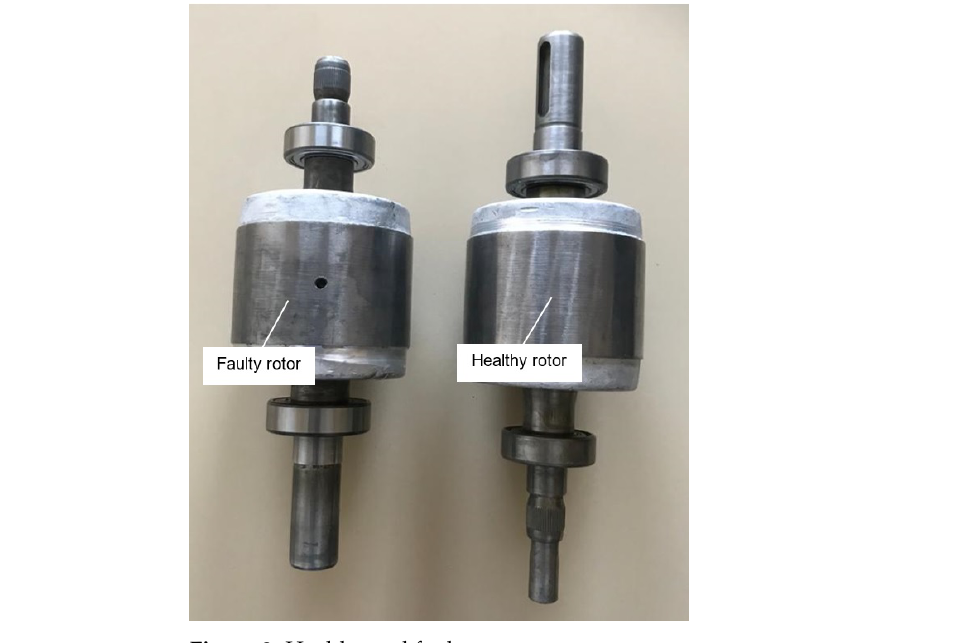
Figure 3. Healthy and faulty rotors.